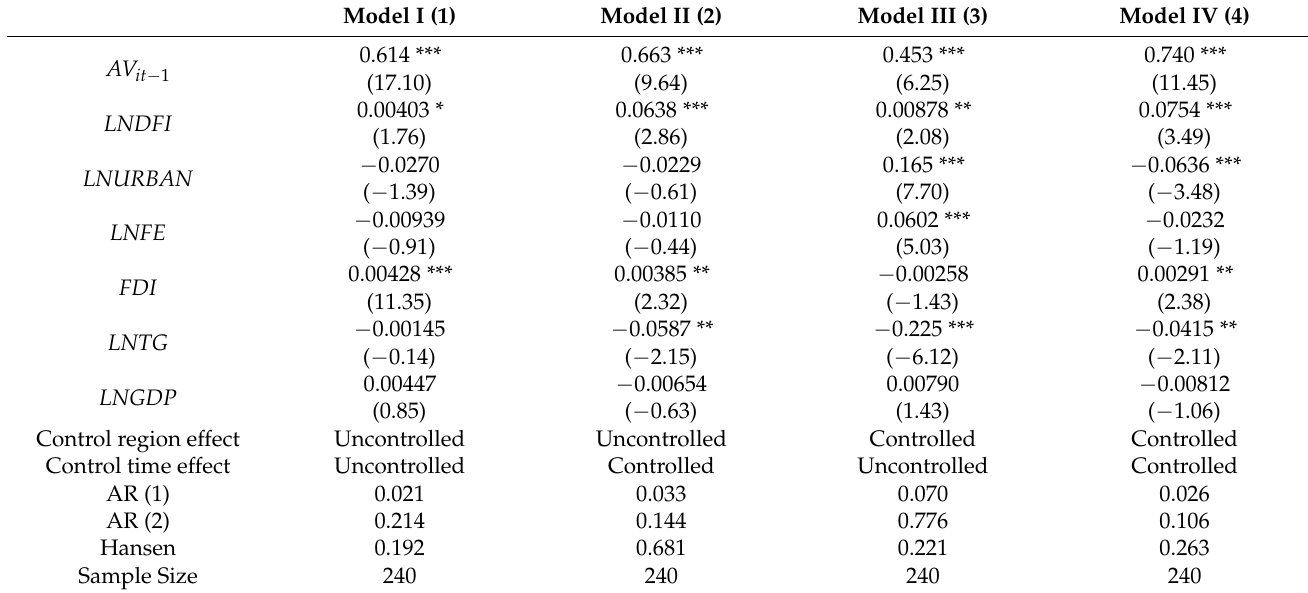
Table 5. Estimated results of the impact of digital financial inclusion on overall agricultural multi-